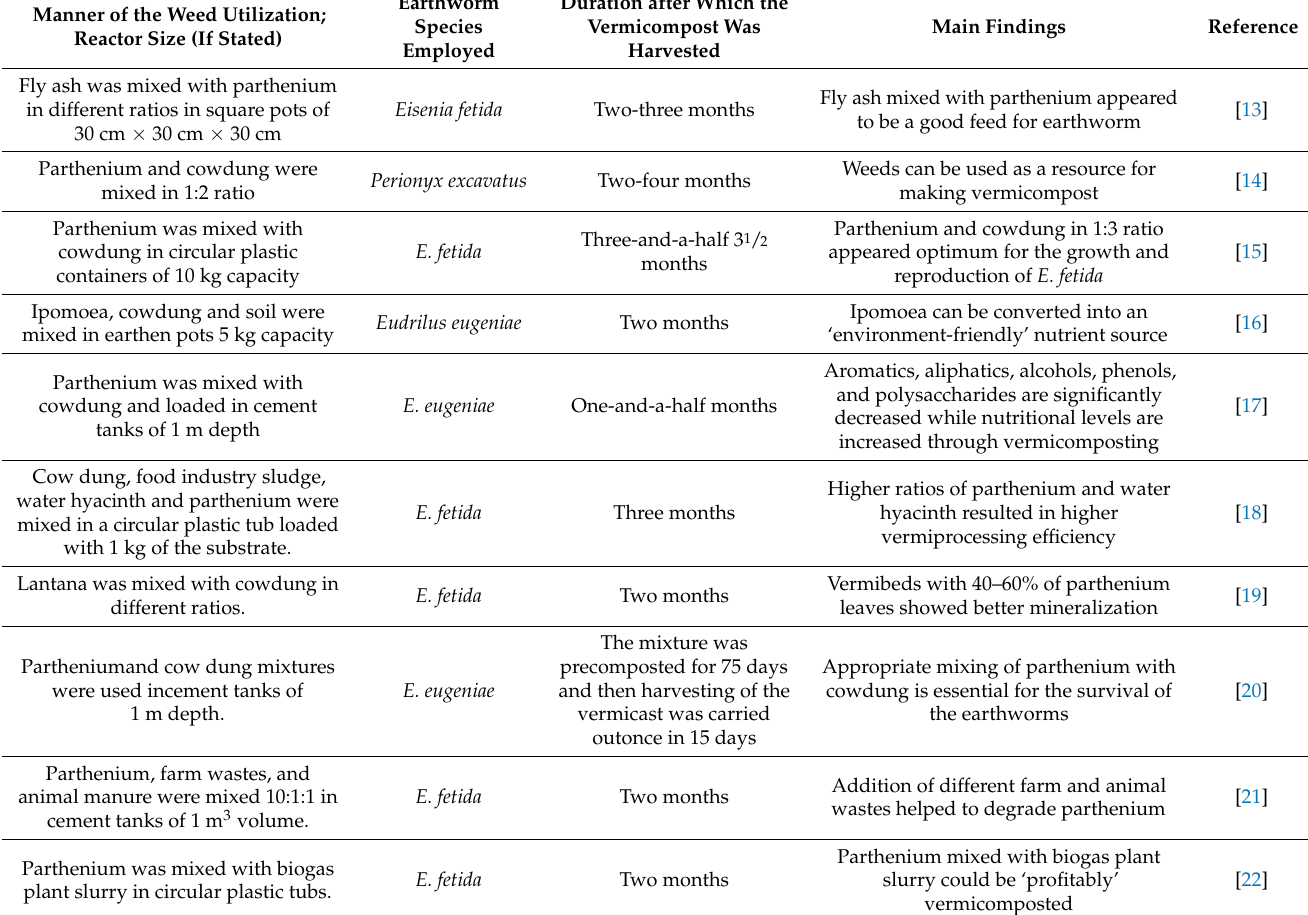
Table 1. A summary of past attempts at the utilization of lantana, parthenium, and ipomoea as feed in vermireactors. All vermireactors were operated in batch mode and no quantifiable measure has been given by any of the authors with which it was decided that vermicomposting had been